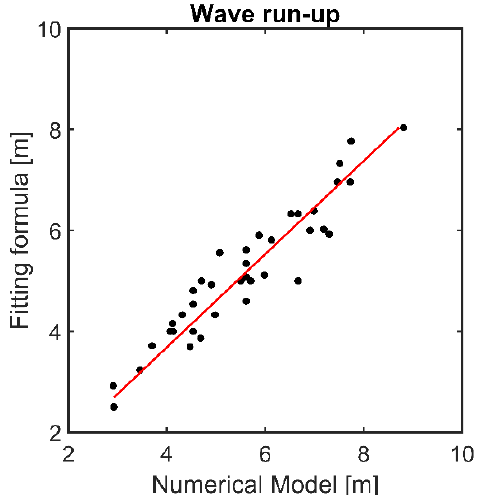
Figure 17. Wave run-up from the numerical model results versus from the fitting formula.